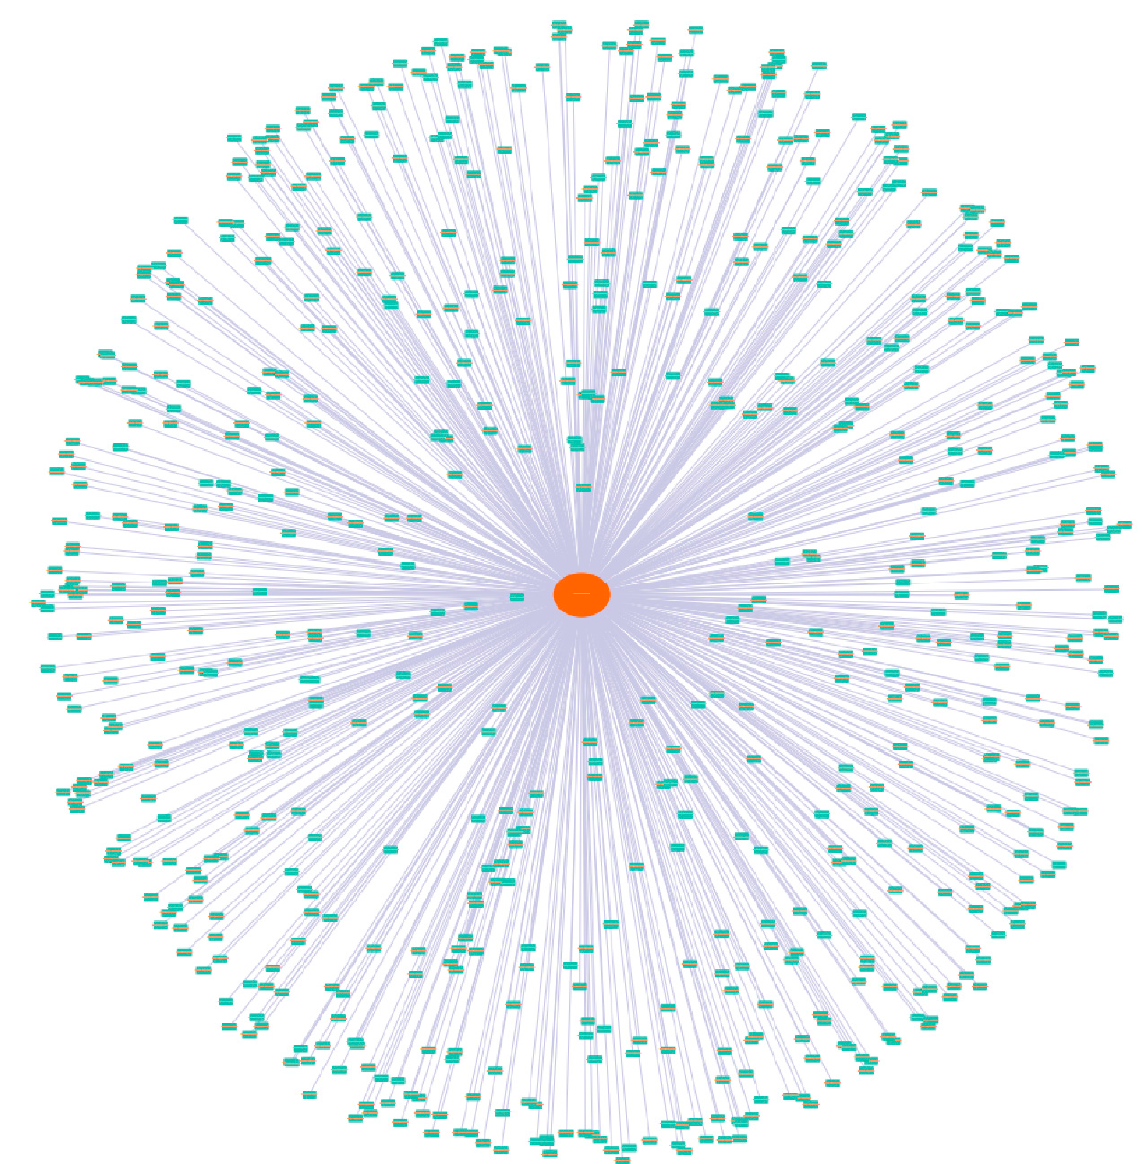
Figure 8. The LSM7-7A related genes in the co-expression network. The orange dots represent the LSM7-7A gene, and the green rectangles represent the genes associated with LSM7-7A.